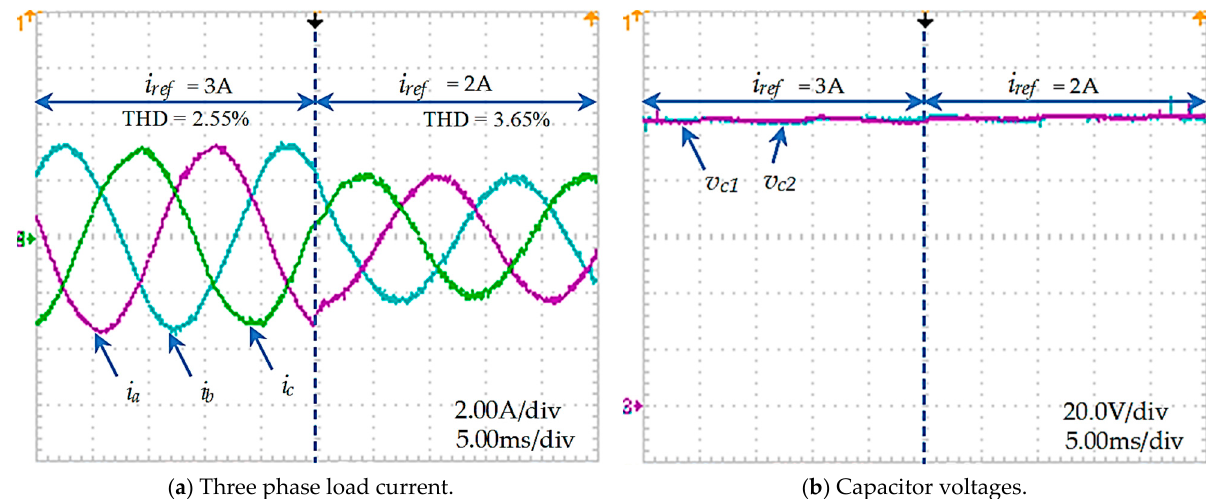
Figure 21. Transient response of the improved PMC for an asymmetric T − type NPC inverter.